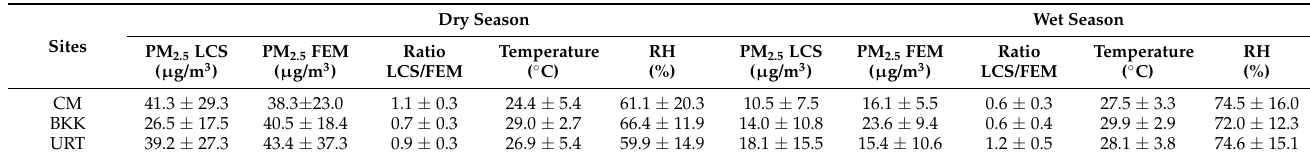
Table 3. Summaries of average PM 2.5 FEM concentrations, ratios of LCS to FEM, RH and temperature ( ± standard